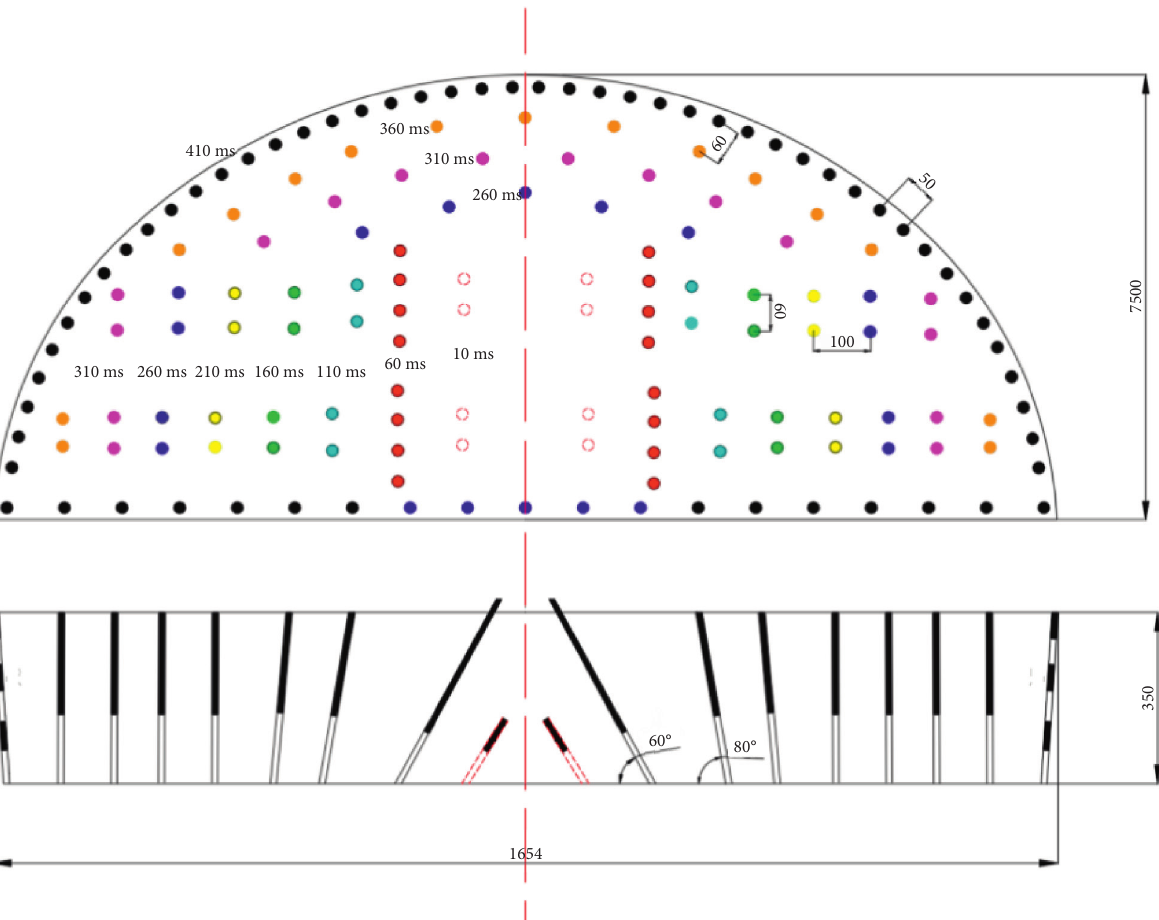
Figure 2: Layout of blast holes on the upper steps of the right line tunnel (unit: mm).